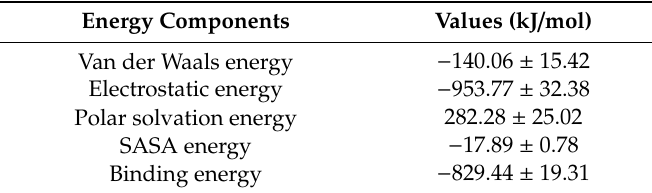
Table 2. Calculation of binding free energy using molecular mechanics Poisson–Boltzmann surface area (MM-PBSA).